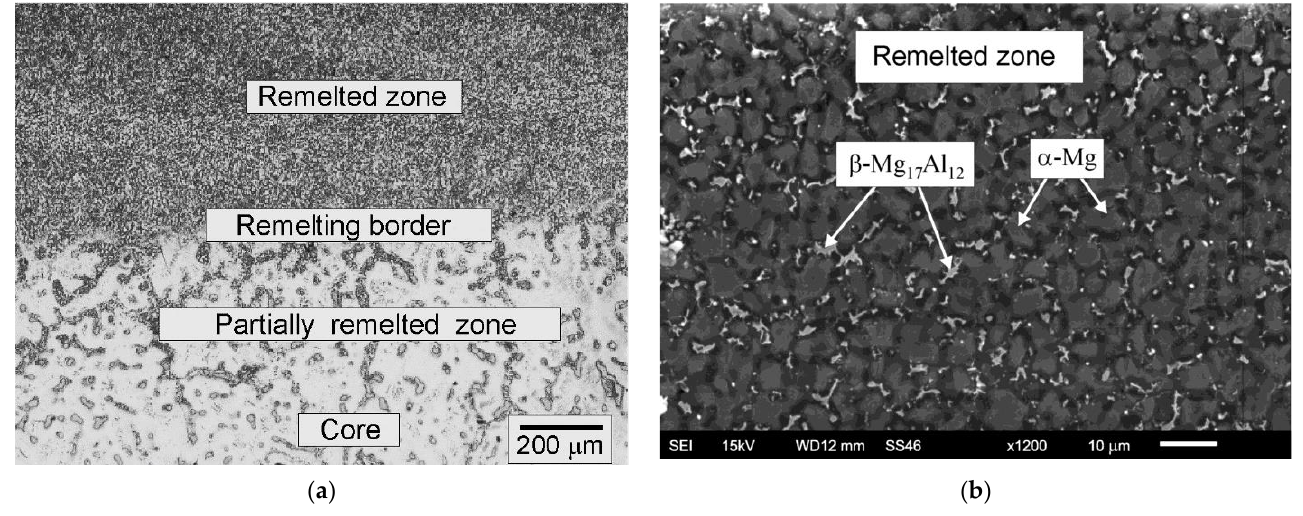
Figure 4. Microstructures of AZ91 magnesium alloy after remelting with current in cleaning burner I = 98 A, and current in remelting burner I = 100 A, ( a ) light microscopy, ( b ) SEM. The size and nature of the changes found in the surface layer prove that the material was melted and then crystallized rapidly. The occurrence of the rapid crystallization phe- nomenon is a natural consequence of a high-temperature gradient and a very short time of interaction of the heat source with the examined magnesium alloy.